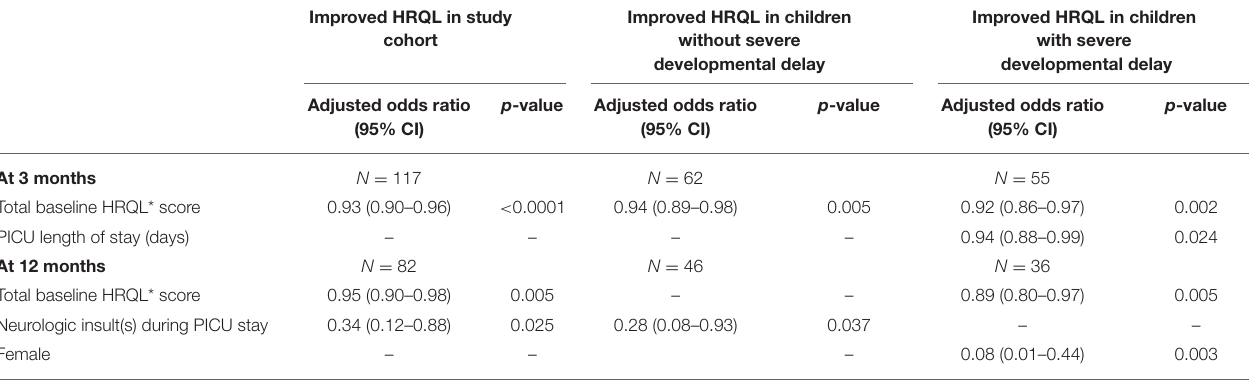
TABLE 3 | Multivariable analyses of improved